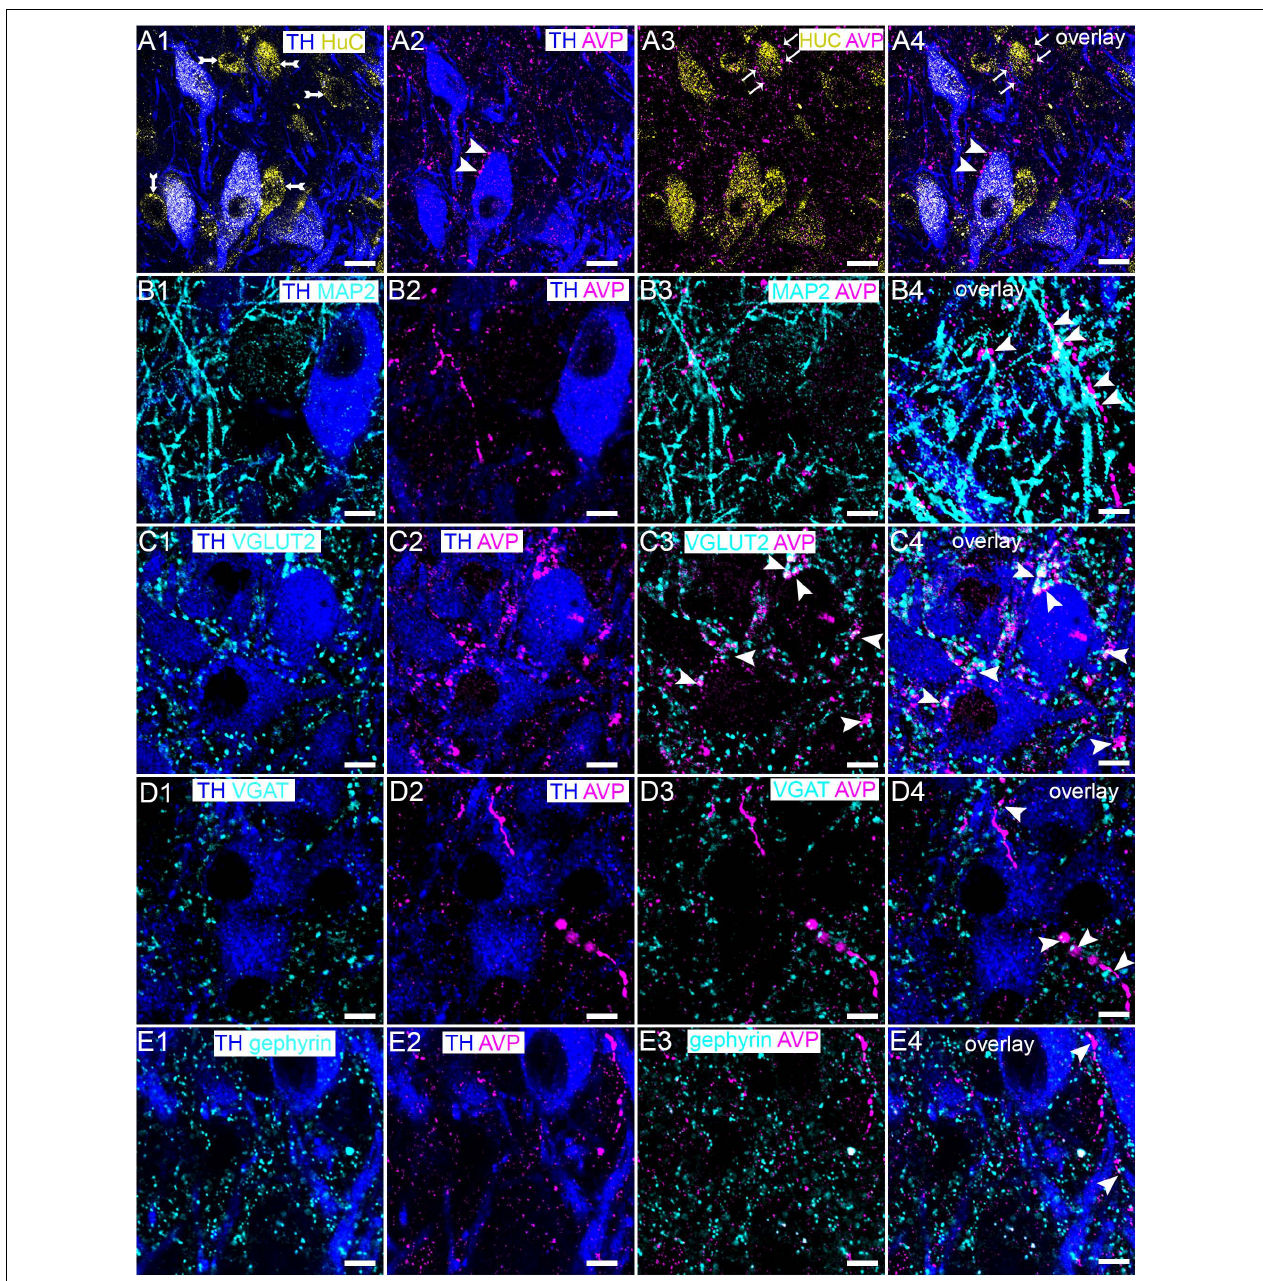
FIGURE 7 | Native AVP-containing axonal profiles contact both noradrenergic and non-noradrenergic LC neurons in close proximity to glutamatergic and GABAergic synapses. (A1) Shows immunoreactivity for TH (blue) and HuC (yellow), indicating the distribution of noradrenergic and non-noradrenergic neurons (double arrow) (A2) shows, in the same field of view, immunoreactivity for TH (blue) and AVP (magenta) immunoreactive profiles contacting LC noradrenergic neurons (arrowhead). (A3) Shows, in the same field of view, immunoreactivity for AVP (magenta) and HuC (yellow), confirming the association of AVP with LC non-noradrenergic neurons as well (arrows). (A4) Is an overlay of (A1–A3) . (B1) Shows immunoreactivity for TH (blue), and MAP2 (cyan). (B2) Shows, in the same field of view, immunoreactivity for TH (blue) and AVP (magenta). (B3) Shows, in the same field of view, the association of immunoreactivity for AVP (magenta) with MAP2 (cyan). Note the close apposition of the AVP-immunopositive varicosity with the dendritic profile (arrowheads). (B4) Is an overlay of (B1–B3) . (C1) Shows immunoreactivity for TH (blue), and VGLUT2 (cyan). (C2) Shows, in the same field of view, immunoreactivity for TH (blue) and AVP (magenta). (C3) Shows, in the same field of view, the